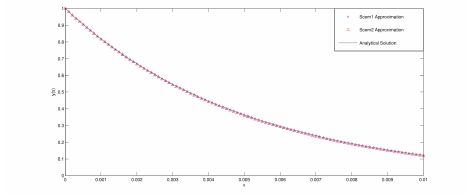
Figure 3. Comparison of the analytical solution and SCEM approximations in solving left symmetric problem for Equations (4.7)–(4.8); ε = 0 . 01. The analytical solution and SCEM approximations are almost identical.